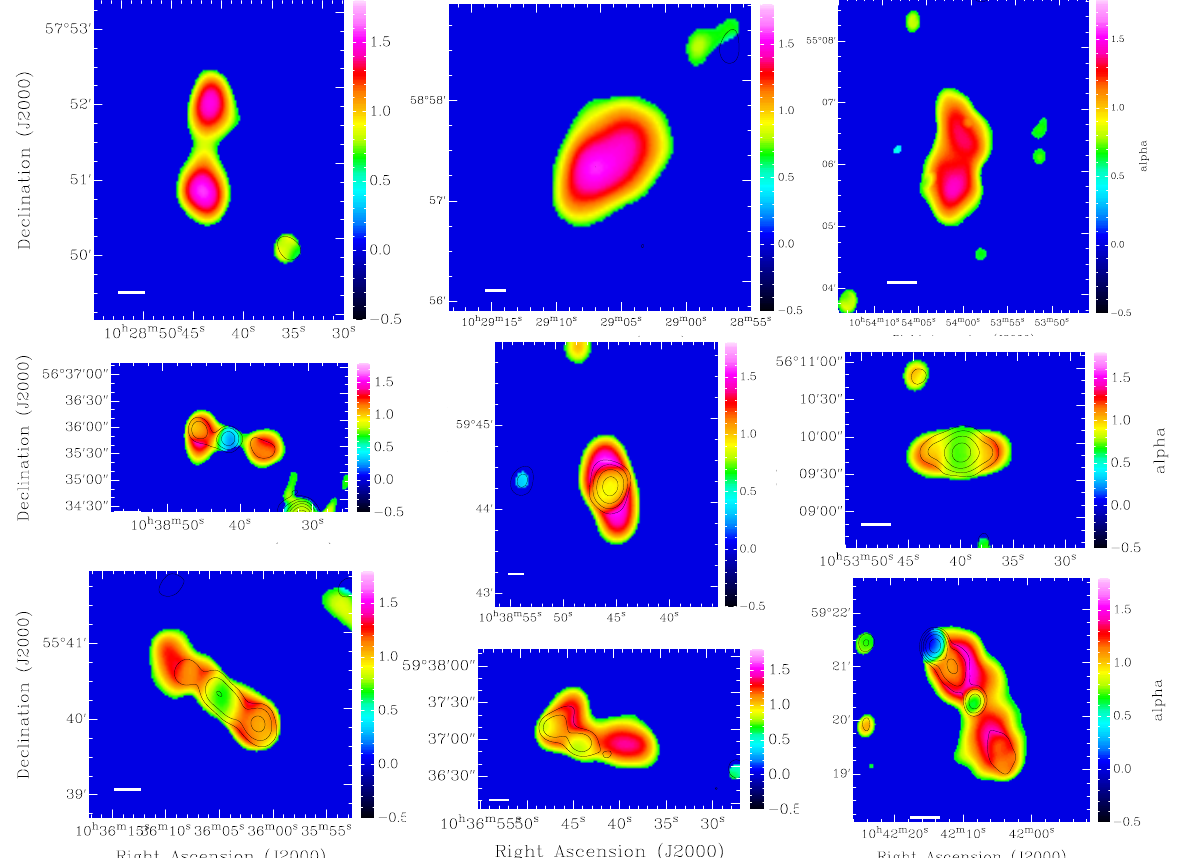
Figure 3. Examples of resolved 150–1400 MHz spectral index images from the LH area, illustrating cases of remnant (top row), restarted candidates (middle row), and not-confirmed remnant radio galaxies (bottom row) from [34,39], see text for details. The complex structure of the spectral index is clearly seen in some of these objects. The contours represent the 1400 MHz emission from Apertif. Regions where no contours are drawn, correspond to Apertif non-detections. In these regions, the spectral index values are lower limits (i.e., the actual spectral index is steeper than what indicated). For the three remnant sources in the top row, Apertif does not detect emission over the full source, and these are entirely USS sources. The white bar indicates 100 kpc (assuming an average redshift of these sources, z ∼ 0.5, see [34,37]). The colour scale is the same as in Figure 2. The artificially flatter spectral index at the edge of the sources results from using a fixed value for the 1400 MHz flux (5- σ ) in case of Apertif non-detection, see Section